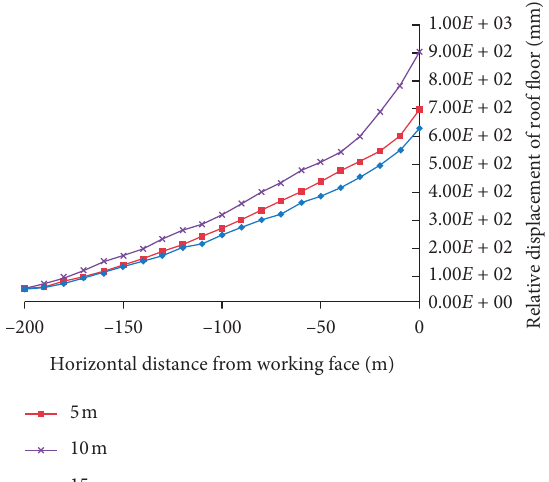
Figure 18: Relative vertical displacement curve of roadway roof and floor at different pillar